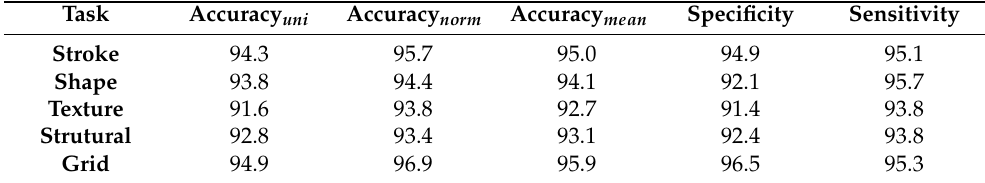
Table 3. Accuracy, specificity, and sensitivity for various features.